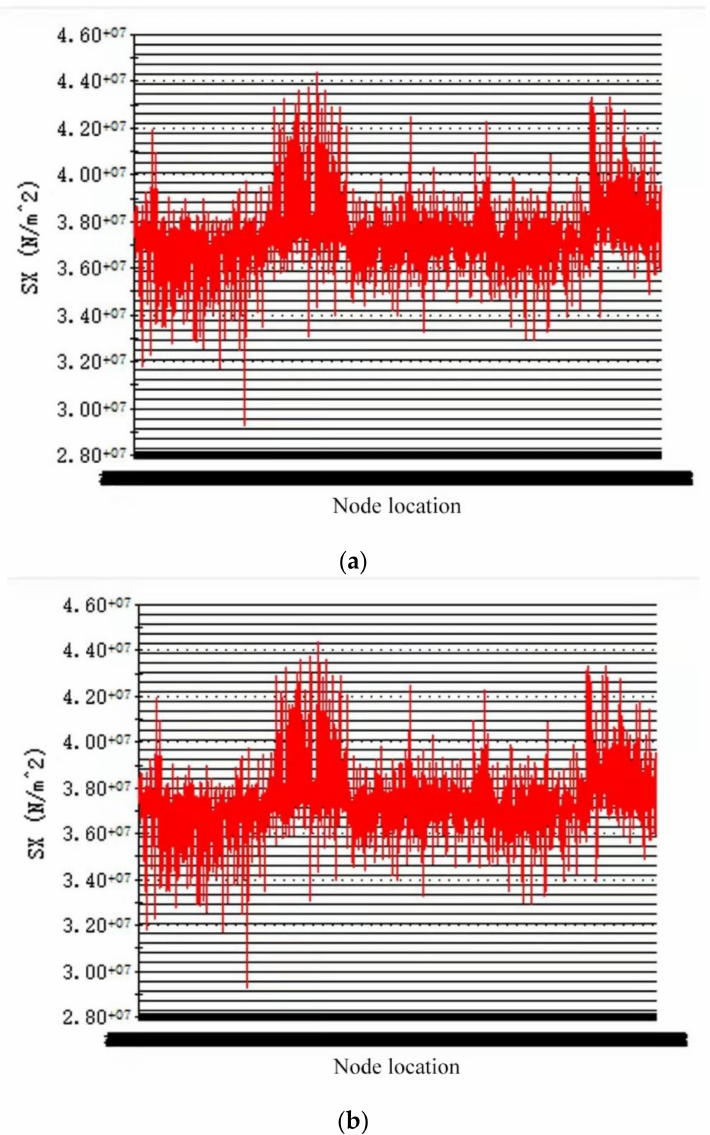
Figure 14. ( a ) Detection of contact surface of contact pressure conductor. ( b ) X-axis orthogonal conductor contact surface detection diagram.